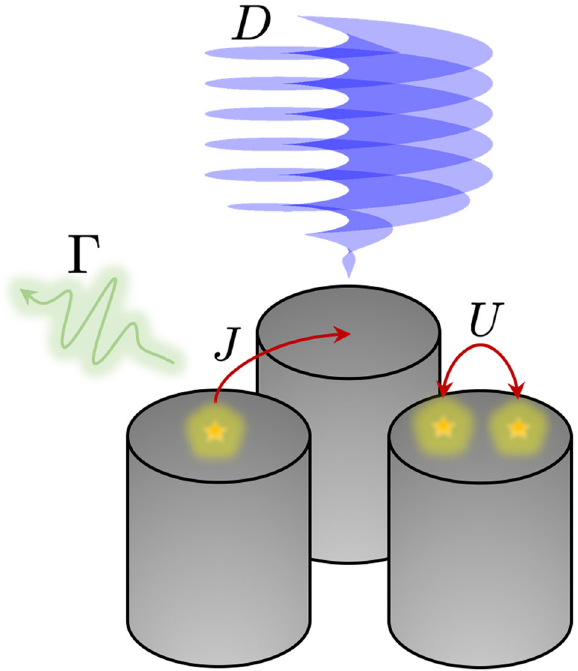
Fig. 1 Illustration of the main setup considered in the text. A ring of M = 3 coupled cavities interacting with chiral light, with hopping J , on-cavity interaction U , dissipation Γ , and chiral drive D .